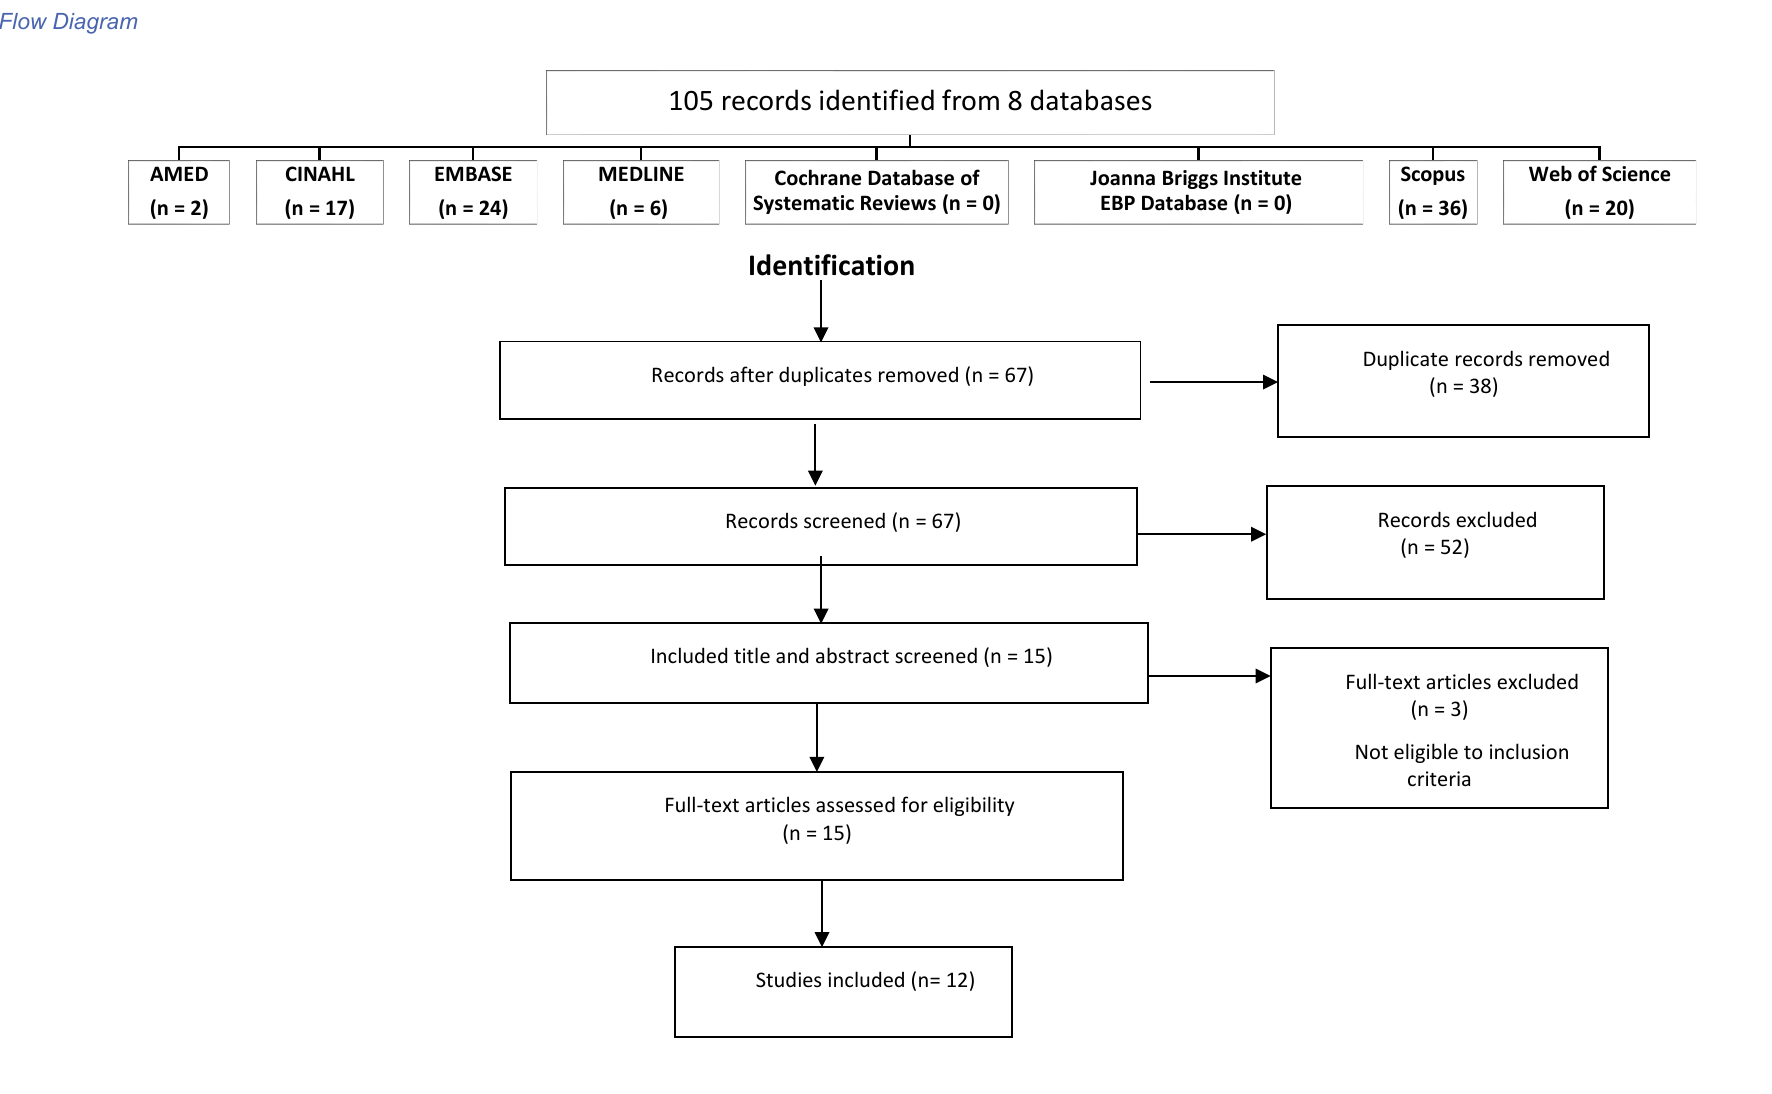
Figure 1 PRISMA Flow